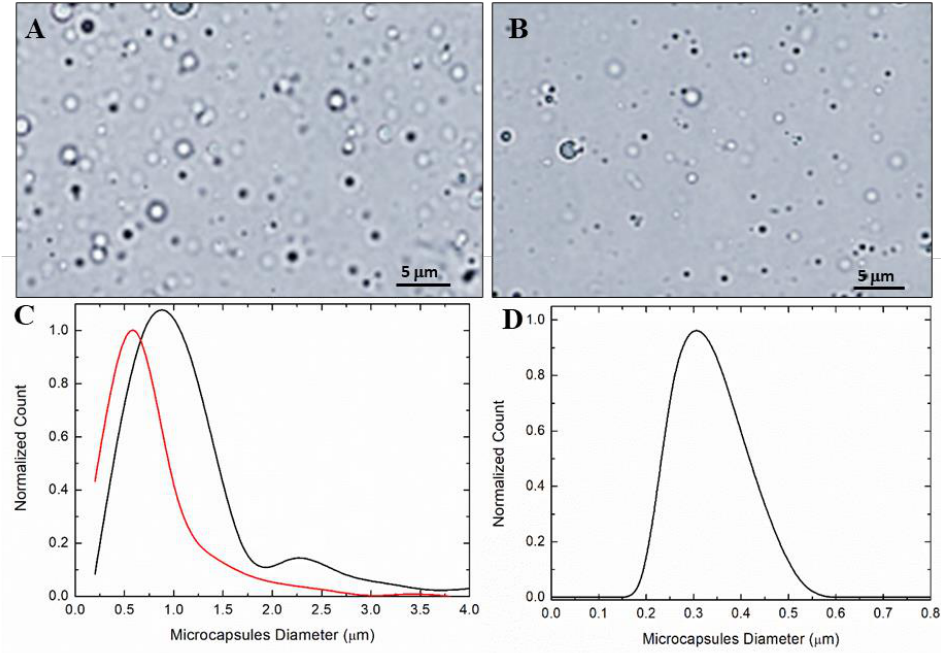
Figure 8. Optical microscopy images of day one ( A ) and after one month ( B ) of OG mc prepared using 10 mg/mL OG + 50 µ L VitD ( C ) Comparison between size distribution of OG mc with VitD (red) and OG mc prepared using 10 mg/mL OG + 50 µ L SO. ( D ) Size distribution of OG mc with VitD after one- month storage.